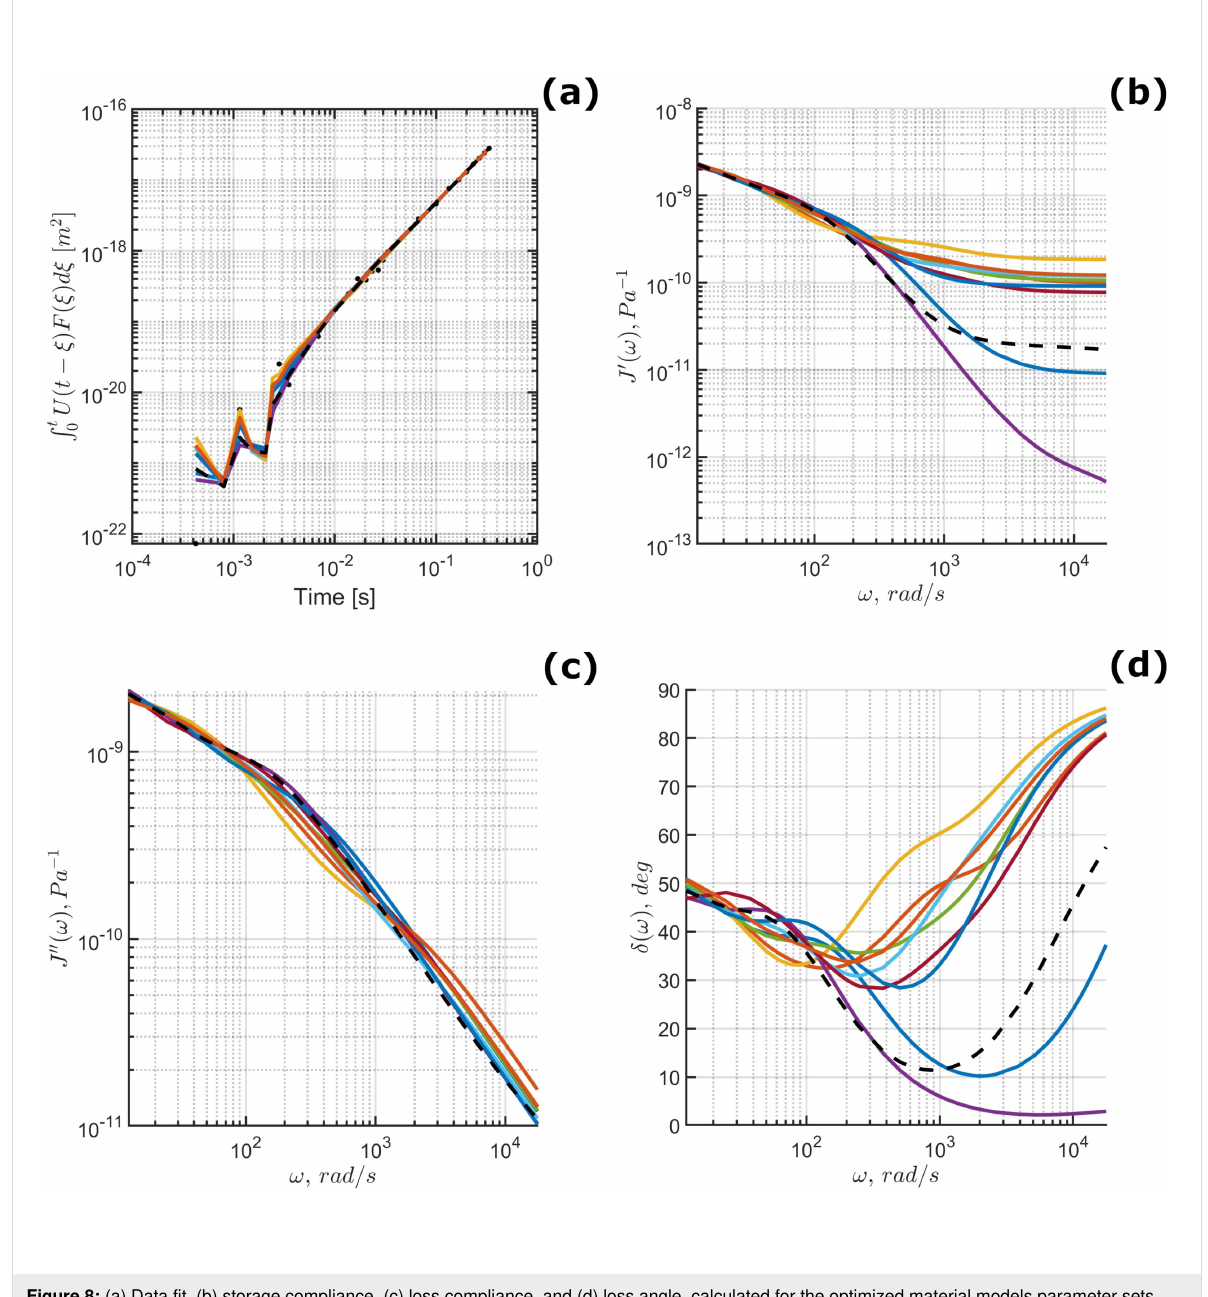
Figure 8: (a) Data fit, (b) storage compliance, (c) loss compliance, and (d) loss angle, calculated for the optimized material models parameter sets ranked 1–10 based upon normalized residual; 10 nm/s approach velocity. Note that the highest ranked fit is given by a dashed black line and the colored lines represent the ranks 2–10. Clearly there can be significant differences in the predicted harmonic quantities while providing a close approximation of the experimental data in panel (a). The loss angle variances shown in panel (d) are driven by significant changes in the storage compliance, shown in panel